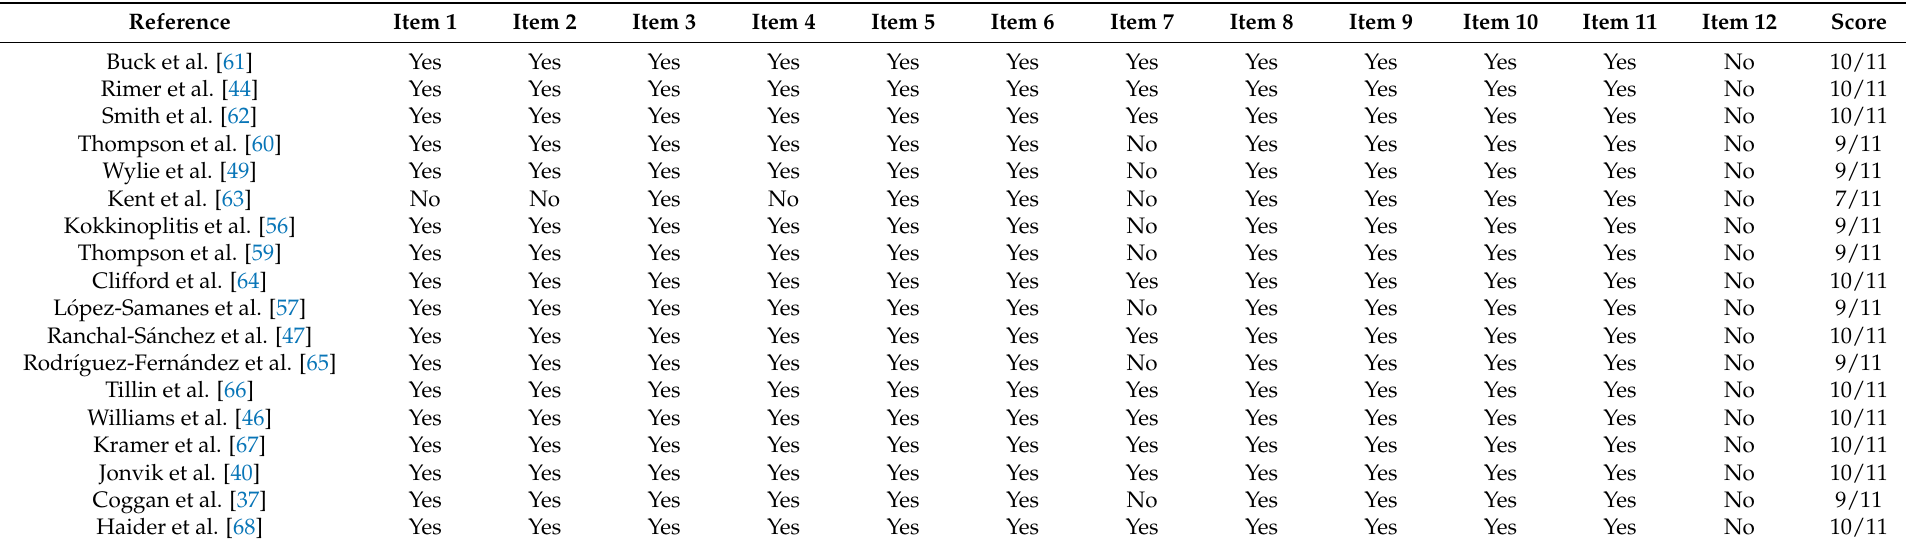
Table 4. Quality assessment of